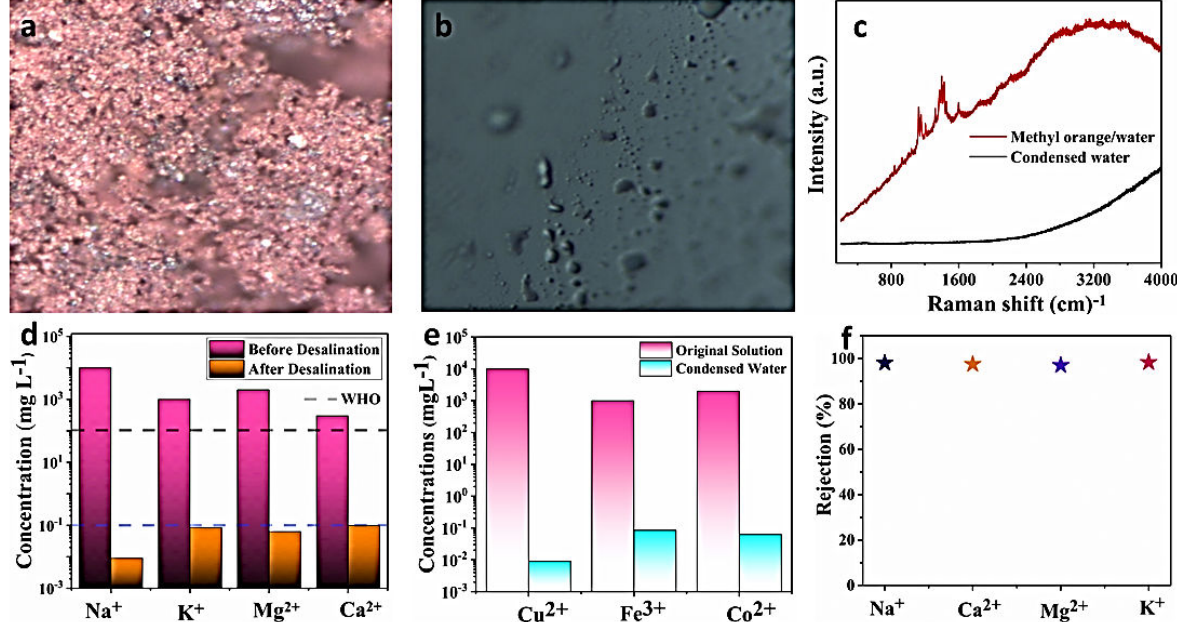
Figure 6. ( a , b ) Microscopical image of methyl orange/water solution and condensed water after evaporation through Fe 2 O 3 @PPy solar evaporator during Raman spectroscopy. ( c ) Raman spectra of methyl-orange dissolved water and condensed water show no peaks that show excellent degradation. ( d , e ) Concentration of the primary metals ions, and heavy metals ions before and after desalination. ( f ) Complete rejection of primary salt ions in stimulated